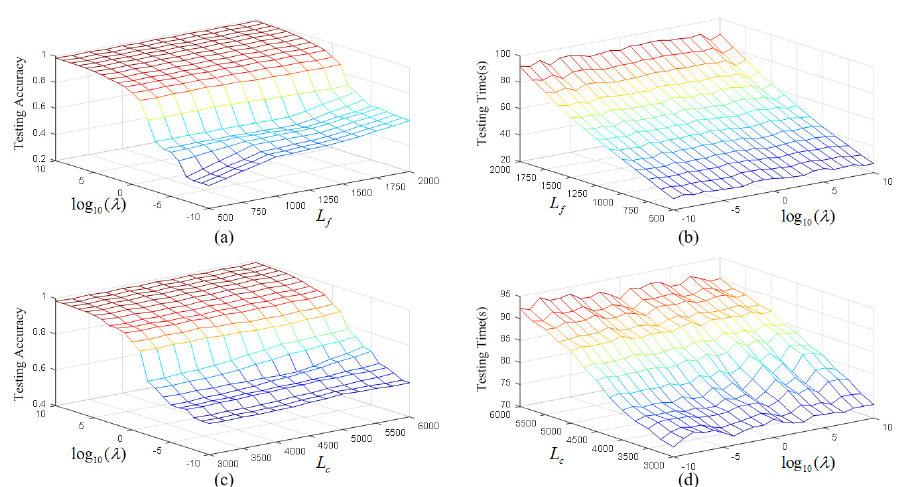
Figure 6. 3D performances plots using different parameter values involving λ , L f , and L c : ( a ) Testing accuracy curve in ( λ , L f ); ( b ) Training time curve in ( λ , L f ); ( c ) Testing accuracy curve in ( λ , L c ); ( d ) Training time curve in ( λ , L c